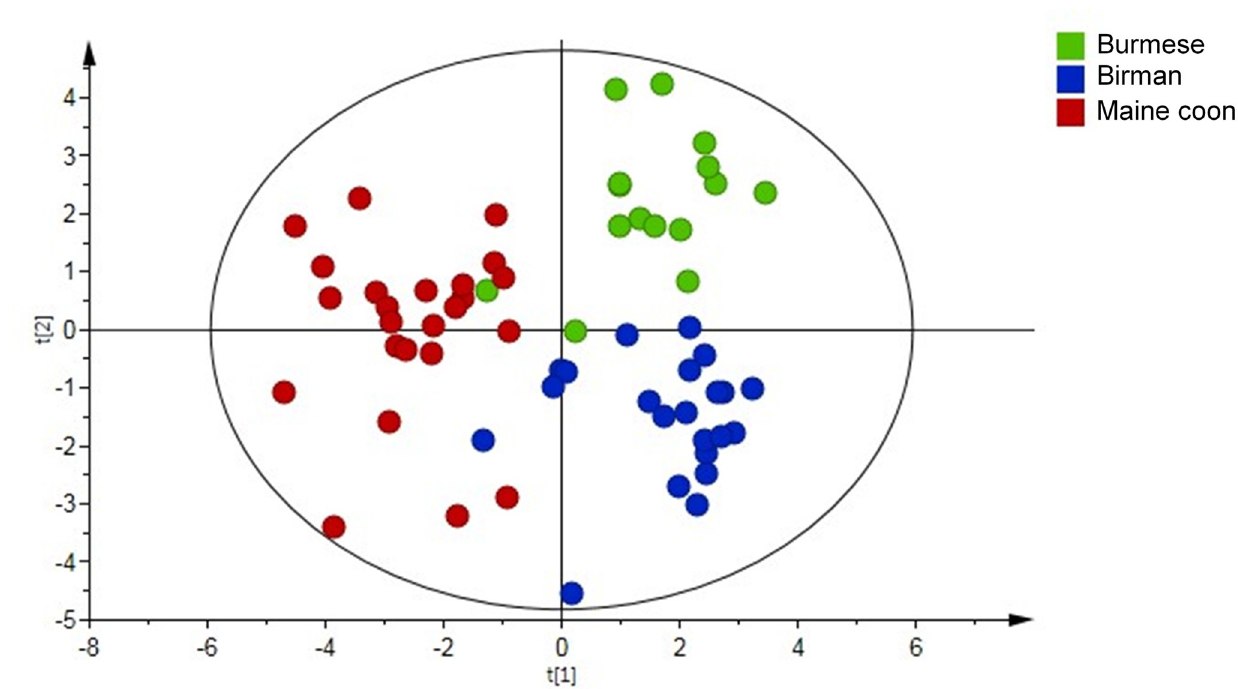
Fig 1. Partial Least Square Discriminant Analysis (PLS-DA) score plot derived from Nuclear Magnetic Resonance (NMR)-based metabolomics analysis in 63 cats by breed; Burmese (n = 15), Birman (n = 23) and Maine coon (n = 25) cats. Each point represents one cat. Model parameters: R2X component 1 = 0.103, R2X compo-